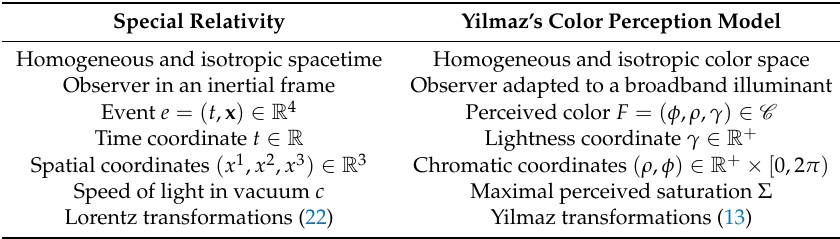
Table 1. Analogies between special relativity and Yilmaz’s model of color